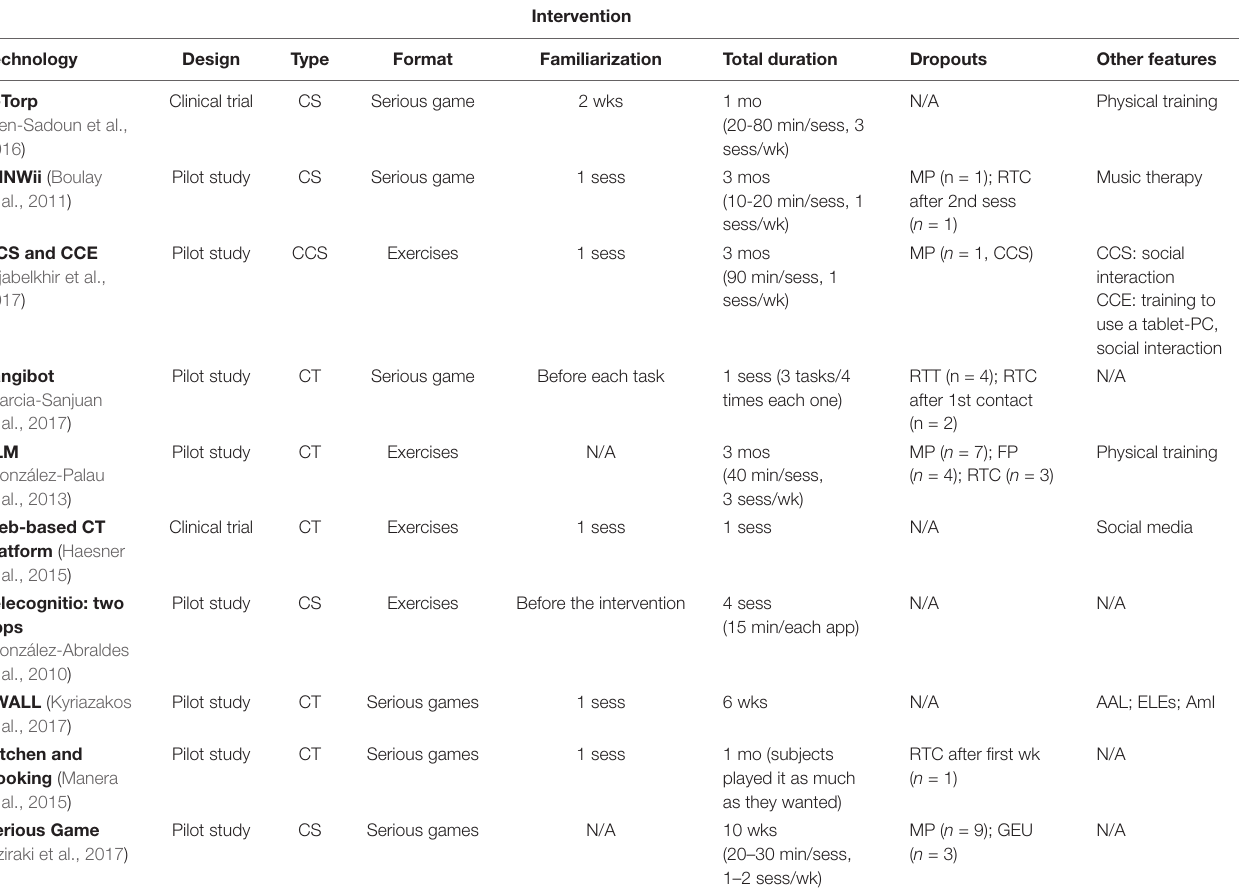
TABLE 3 | Methodological and descriptive characteristics of the